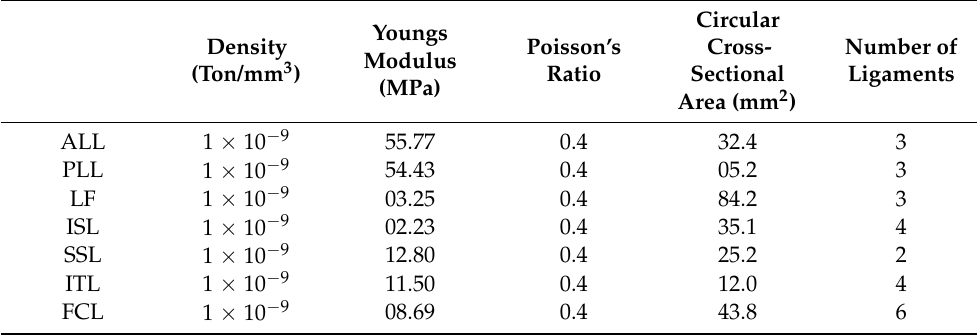
Table 2. The mechanical material constants used for modeling the wire ligaments. Circular cross- sectional area and the ligament number [41,44].